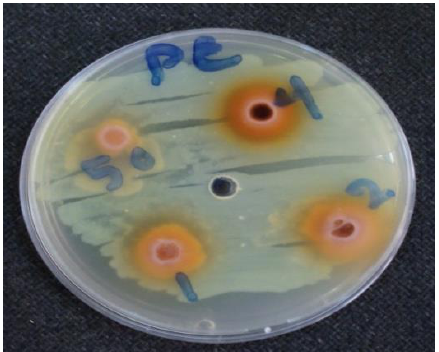
Figure, 4: Inhibition zones of Proteus spp. growth on Mueller-Hinton agar produced by ethanolic extract of Quercusrobur , the peripheral four wells contained extract concentrations ( 50, 100, 200, 400 mg/ml) whereas the central well contained 0.1 ml of 96% ethanol .